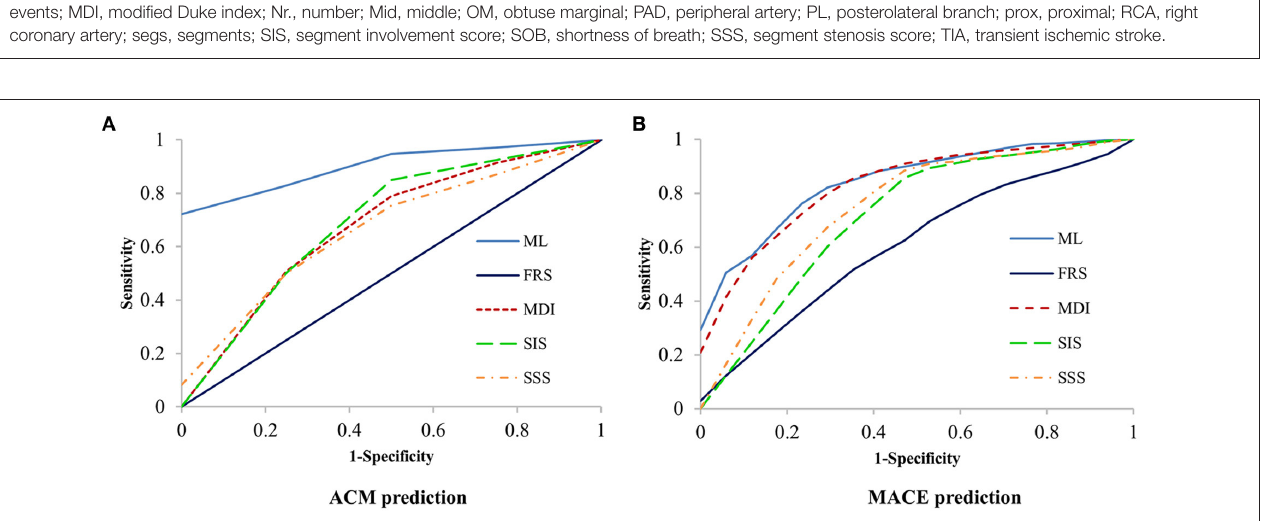
FIGURE 4 | Receiver-operating characteristic (ROC) curves for prediction of ACM and MACE. Machine learning had a significantly higher area-under-the curve for prediction of ACM ( P < 0.001, A ) and MACE ( P < 0.05, B ) than all other scores. ACM, all-cause mortality; FRS, Framingham risk score; MACE, major adverse cardiac events; MDI, modified Duke index; SIS, segment involvement score; SSS, segment stenosis score.